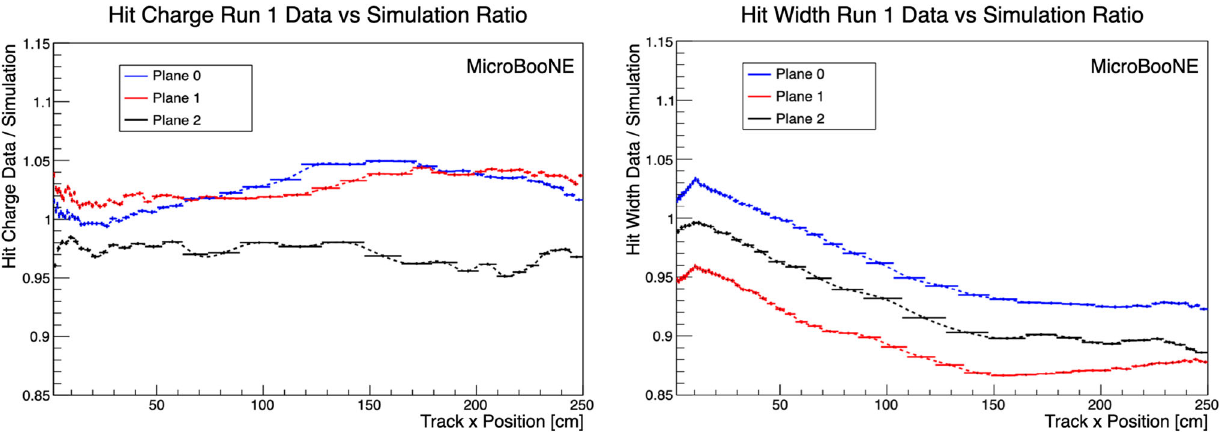
showing the statistical uncertainties, and the dashed lines are spline fits. The width of each bin is indicated by the solid horizontal bars. The binning is chosen to ensure high statistics in each